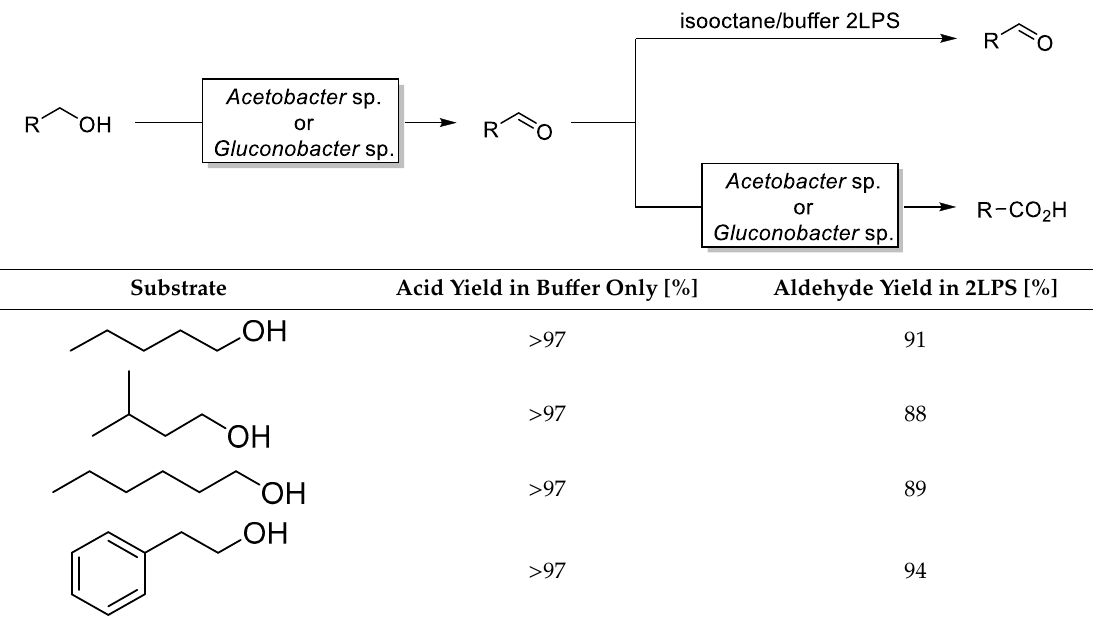
Table 2. Controlling the selectivity of the whole-cell catalyzed oxidation of primary alcohols.